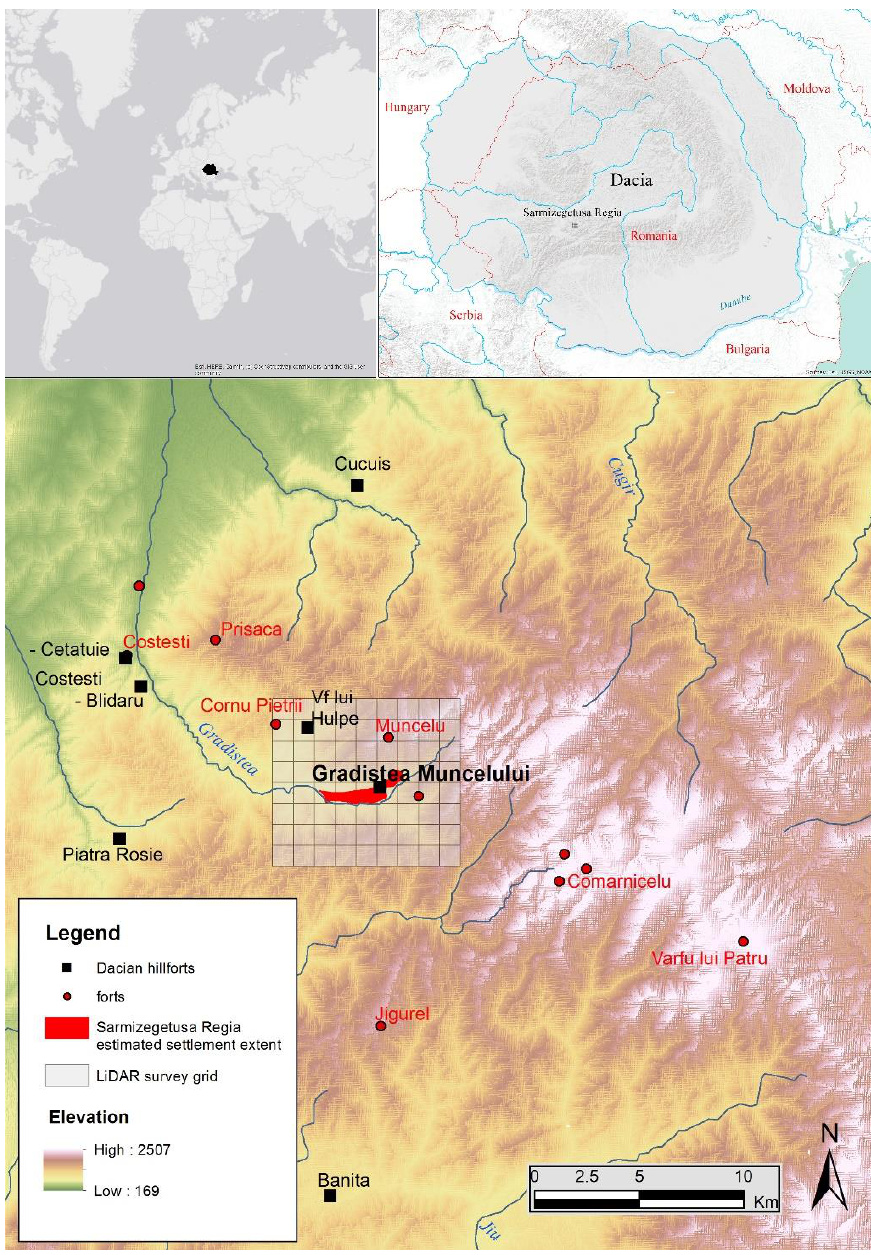
Figure 1. Map of the study area.